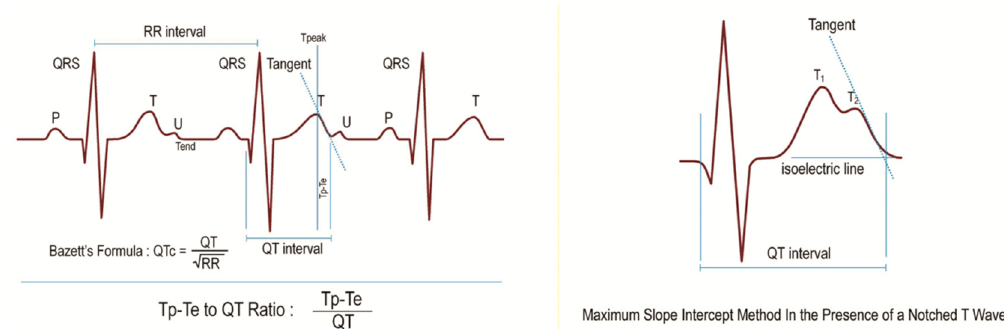
Figure 1. T wave peak-to-end interval (Tp-Te), QT interval, RR interval, Bazzett’s Formula, Tp-e/QT Ratio, and maximum slope intercept method in the presence of a notched T